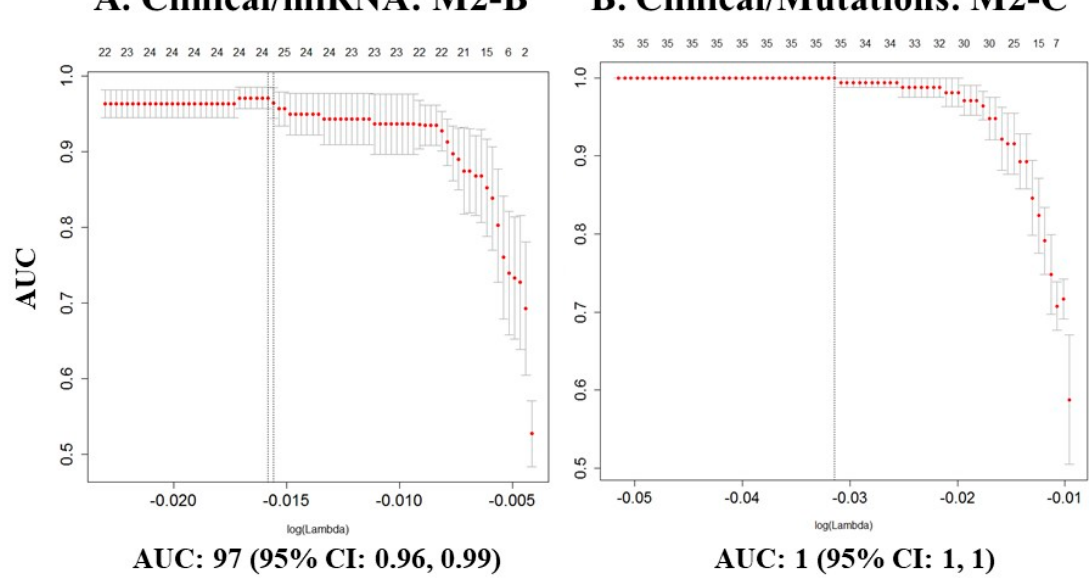
Figure 5. Prediction models with the highest performances. Curves of performance of the models based on AUC. On top of the graphic: number of variables included in the model. On Y -axis: AUC value. On X -axis: lambda value. ( A ) Model including clinical and miRNA variables; ( B ) Model including clinical variables and somatic mutations.